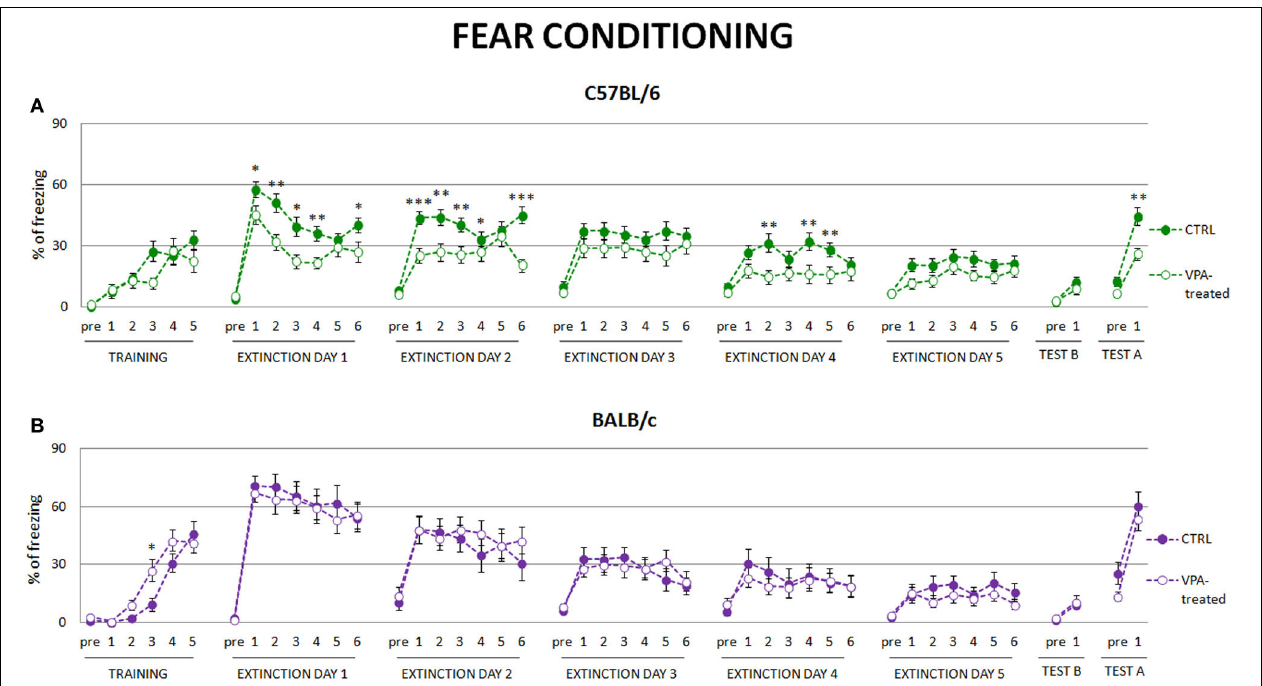
FIGURE 4 | Fear conditioned valproate-treated C57BL/6 mice but not BALB/c mice exhibit lower level of freezing during fear extinction and decreased contextual fear renewal. (A) During extinction session valproate-treated C57BL/6 mice ( n = 20) decreased freezing response to the conditioned stimulus to a larger degree than the control animals, as well as showed decreased fear renewal